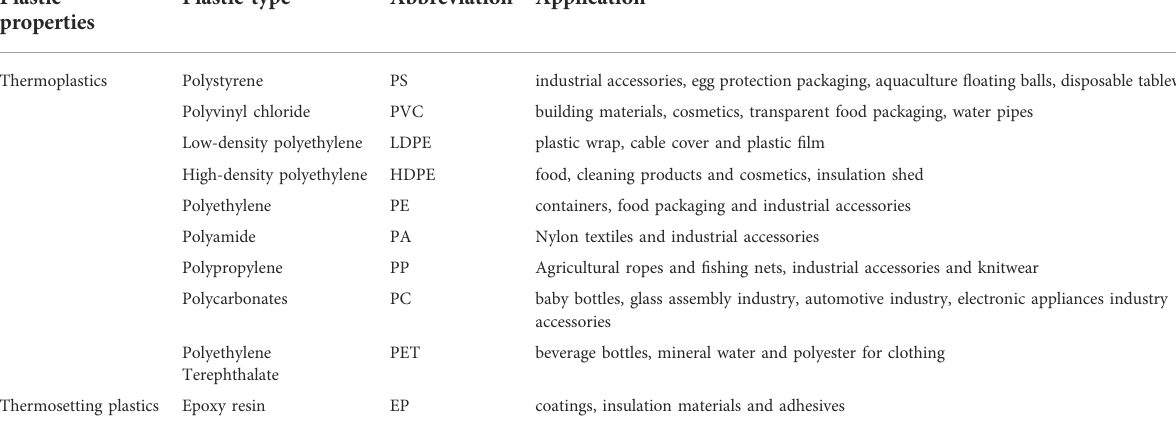
TABLE 1 Classi fi cation and application of typical